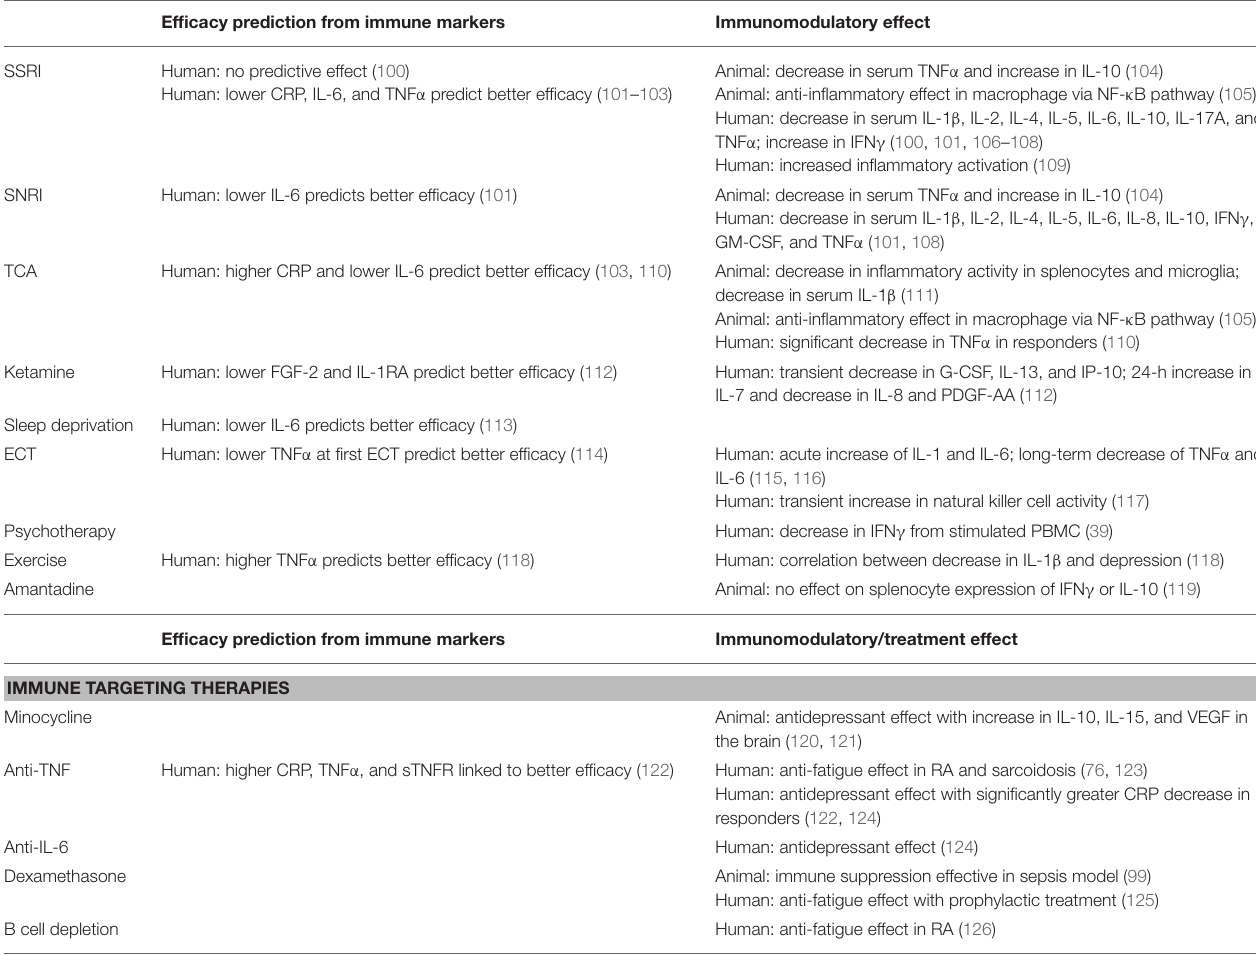
TABLE 1 | Efficacy prediction and immunomodulatory effect of therapies. Efficacy prediction from immune markers Immunomodulatory